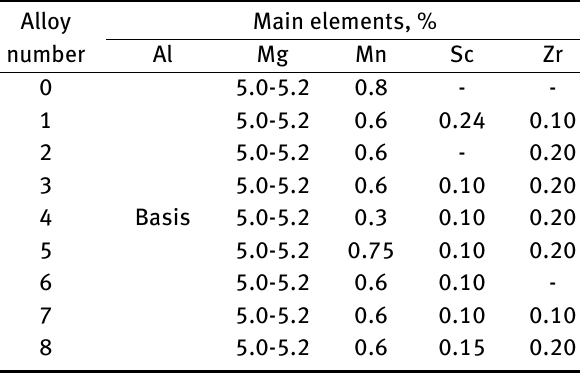
Table 2: The chemical composition of ingots from experimental alloys with a reduced content of Mn and Cr of the Al-Mg system Alloy Main elements,